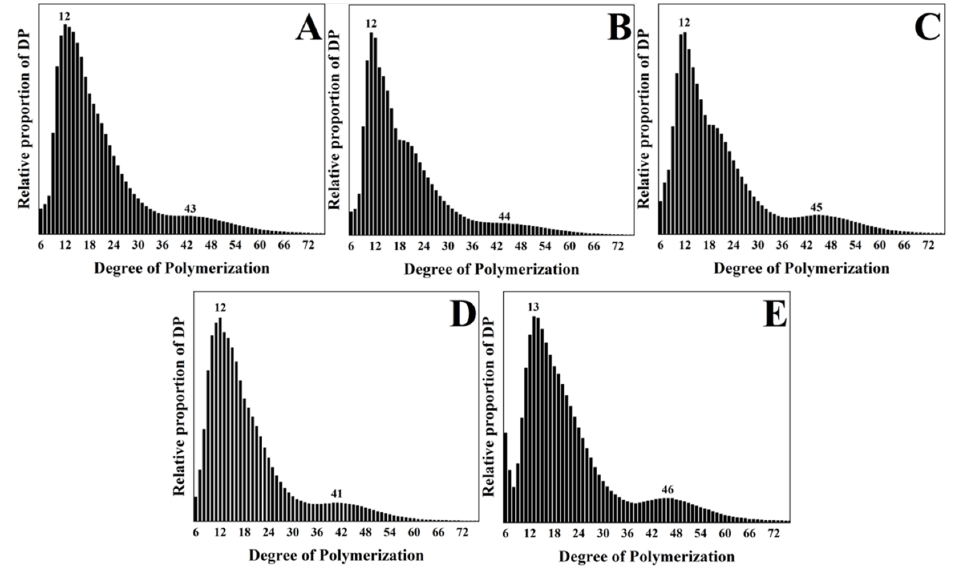
Figure 4. Amylopectin branched chain length distributions of different varieties of starch: ( A ) corn starch; ( B ) wheat starch ( C ) cassava starch; ( D ) rice starch; ( E ) potato starch. Table 1. Branched chain length distributions of amylopectin.